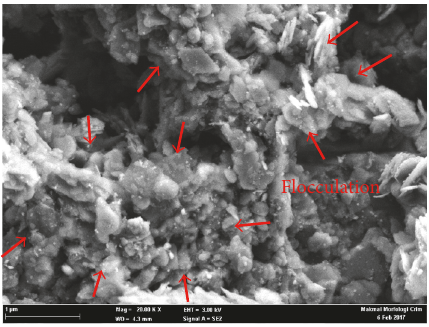
Figure 12: FESEM micrograph of soil-5% lime: Mag = 20.00